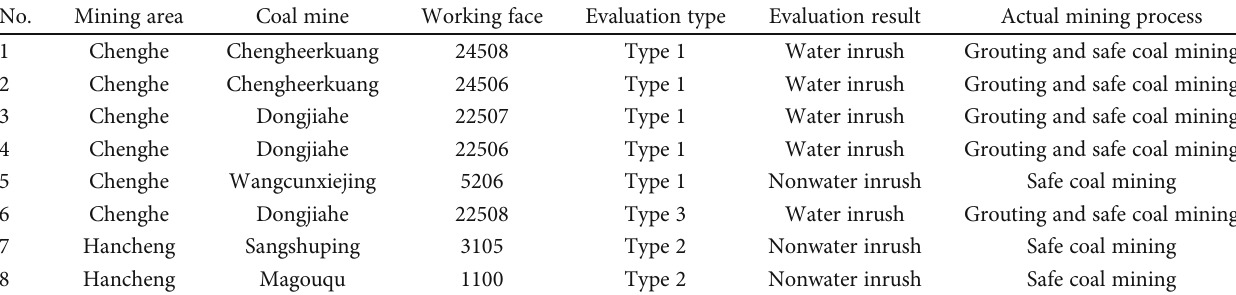
Table 3: Risk prediction of water inrush in coal working faces based on classi fi cation of geological